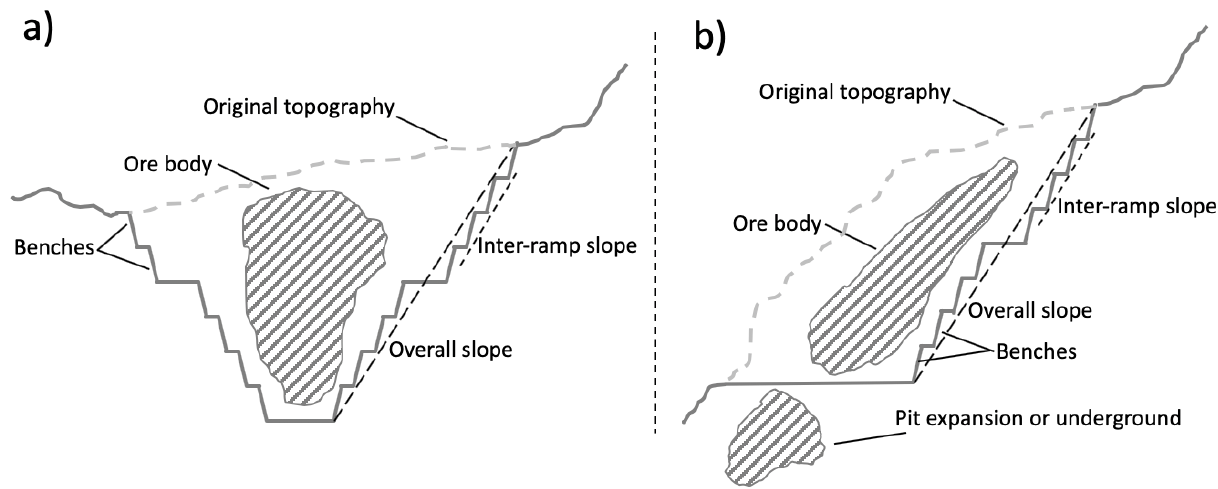
Figure 1. Cross section sketches of typical open pit configurations ( a ) and pit walls on the side of steep slopes ( b ). Not to scale.